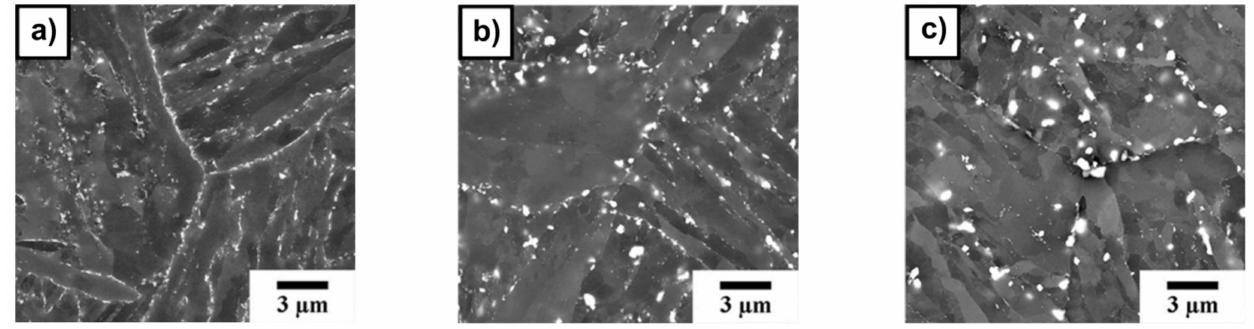
Figure 14. SEM images showing Laves phase and M 23 C 6 particles in the 9Cr-3Co-1.5W steel after creep rupture test at 650 ◦ C: ( a ) 180 MPa, 243 h; ( b ) 140 MPa, 3430 h; ( c ) 100 MPa, 17,863 h. Reprinted with permission from Ref. [38]. Copyright 2019